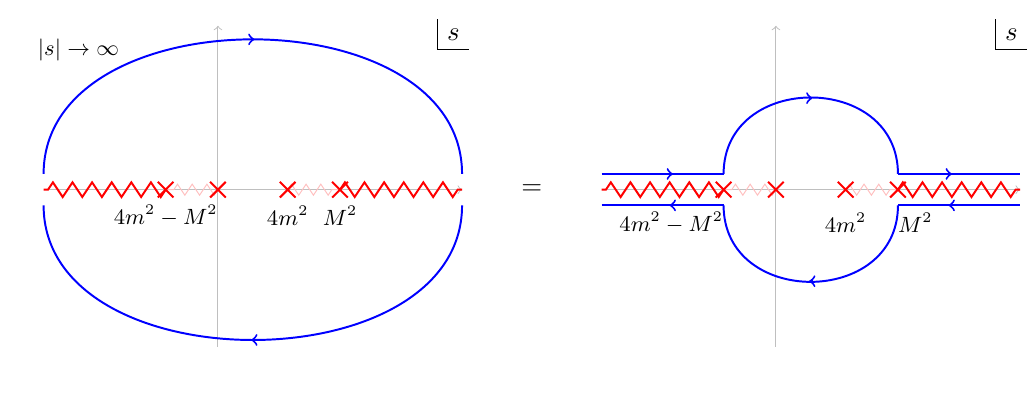
Figure 1 . The contour deformation implementing the dispersive sum rule C k defined in